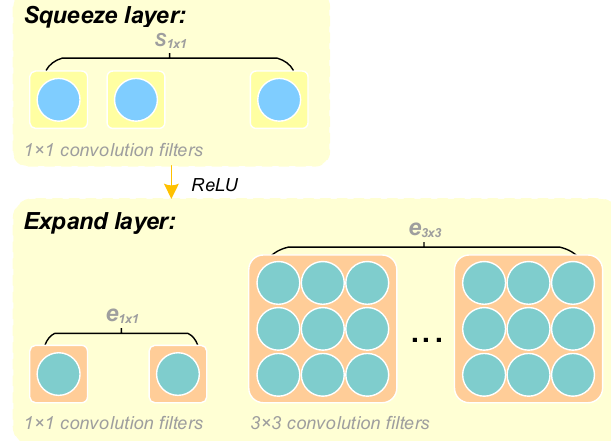
Figure 4. Organization of convolution filters in Fire module.